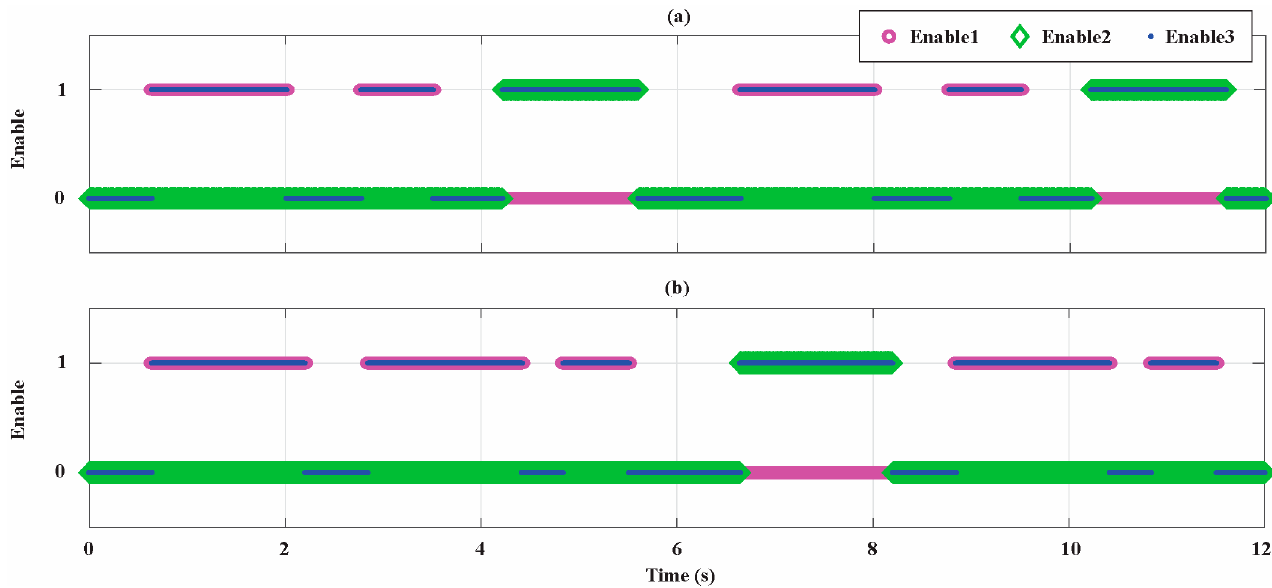
Figure 9. Activation signals for the AdNNs. ( a ) Bonfiglioli 65; ( b ) Bonfiglioli 170.